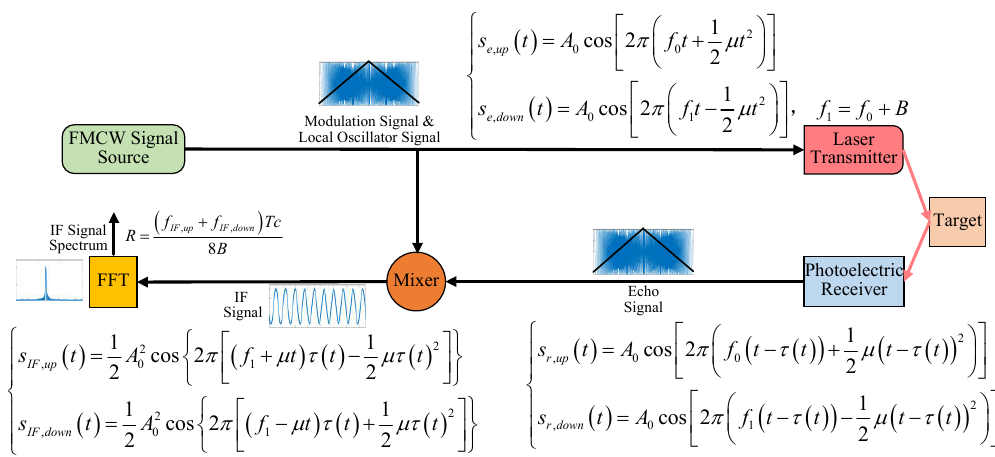
Figure 1. Frequency-modulated-continuous-wave (FMCW) laser detection principle. IF signal of FMCW laser fuze is obtained by mixing the echo signal with the local oscillator signal.